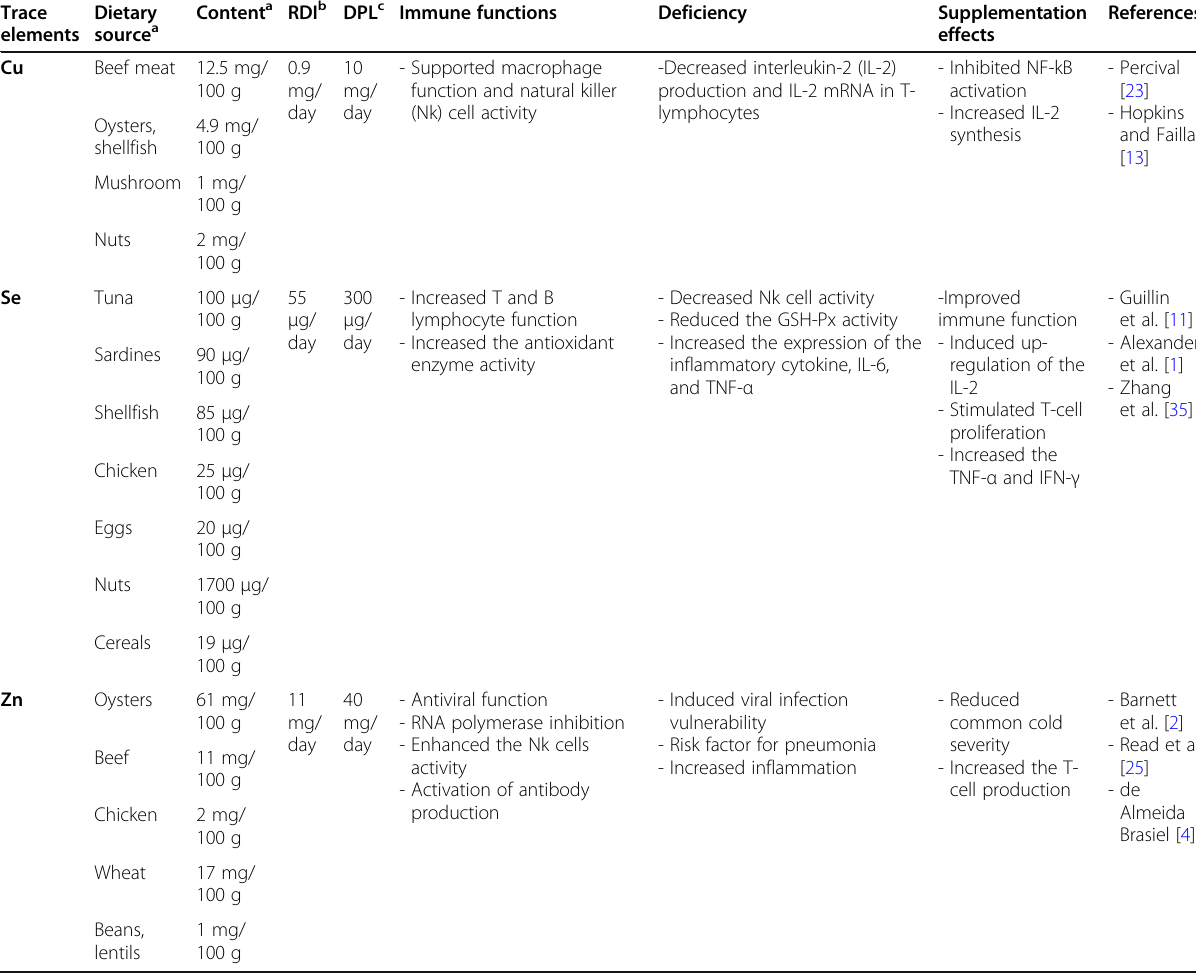
Table 1 Dietary sources, recommended daily intake (RDI), daily permissible limit (DPL), immune functions, and supplementation effects of Cu, Se, and Zn Trace Dietary elements source